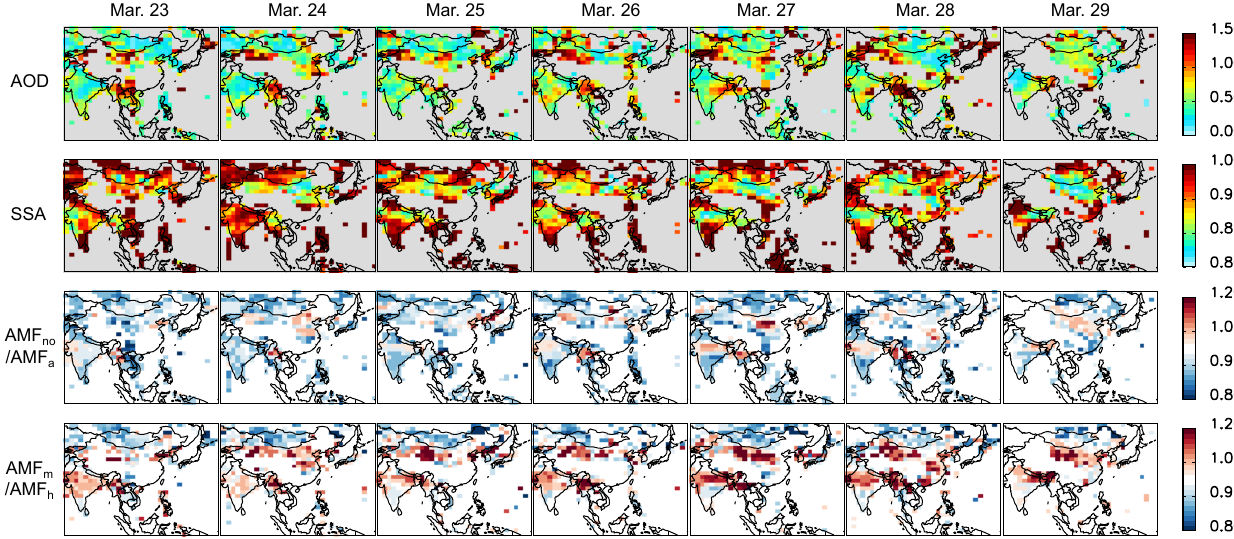
Figure 10. Values of AOD, SSA, aerosol optical property effects on AMFs (AMF no /AMF a ) , and temporal effects of aerosol optical properties on AMFs (AMF m /AMF h ) for 23–29 March 2006, when a strong dust event occurred in East Asia. AMF no and AMF a indicate values without and with aerosols, respectively. AMF m is a value using monthly mean AOD and SSA from OMI. AMF h is a value using AOD and SSA from OMI at each measurement